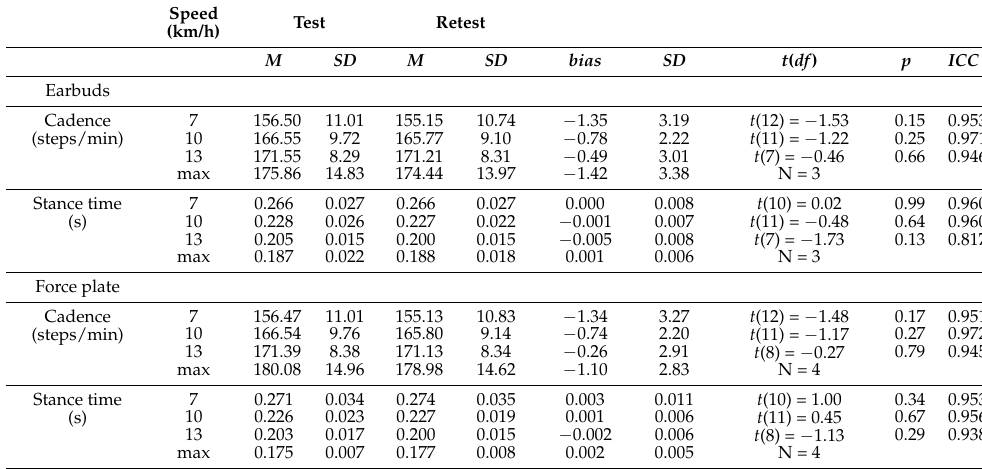
Figure 5. Bland–Altman plots comparing the test and retest data for the earbud ( a , c ) and the force-plate ( b , d ). Each dot represents the test–retest combination for one participant at a particular speed. Table 2. Means, standard deviations and test–retest reliability of the cadence and stance time as measured with the earbud and force-plate methods.